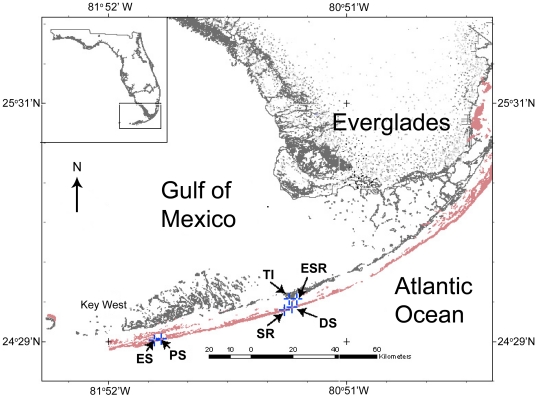
Nearshore (NS) and offshore (OS) queen conch sampling sites in the Florida Keys.Microarray construction: ESR, East Sister's Rock (NS); ES, Eastern Sambo (OS); SR, Sombrero Reef (OS). Microarray and real-time reverse-transcription polymerase chain-reaction experiments: PS, Pelican Shoal (OS); TI, Tingler Island (NS). Validation of 18S rRNA for real-time RT-PCR: PS; TI; ES; ESR; DS, Delta Shoal (OS). Inductively coupled plasma-mass spectrometry and histology: PS; TI; ESR, ES.